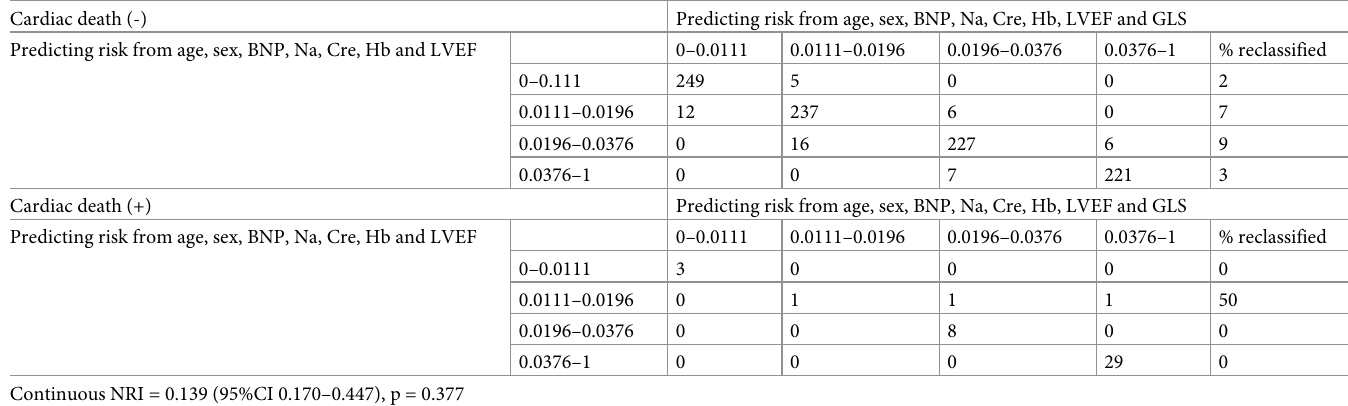
Continuous NRI = 0.139 (95%CI 0.170–0.447), p = 0.377